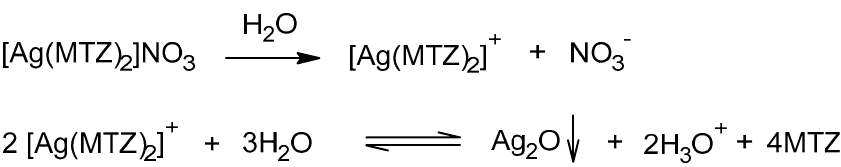
Figure 1. Silver (I) nitrate complex with metronidazole [Ag(MTZ) 2 ]NO 3.